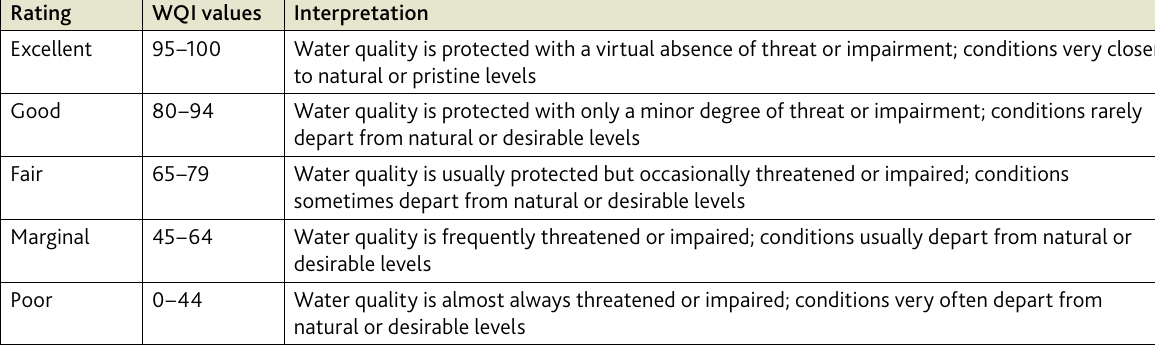
Table 3. Ranking system and interpretation of water quality based on CCME WQI (CCME, 2001) Rating WQI